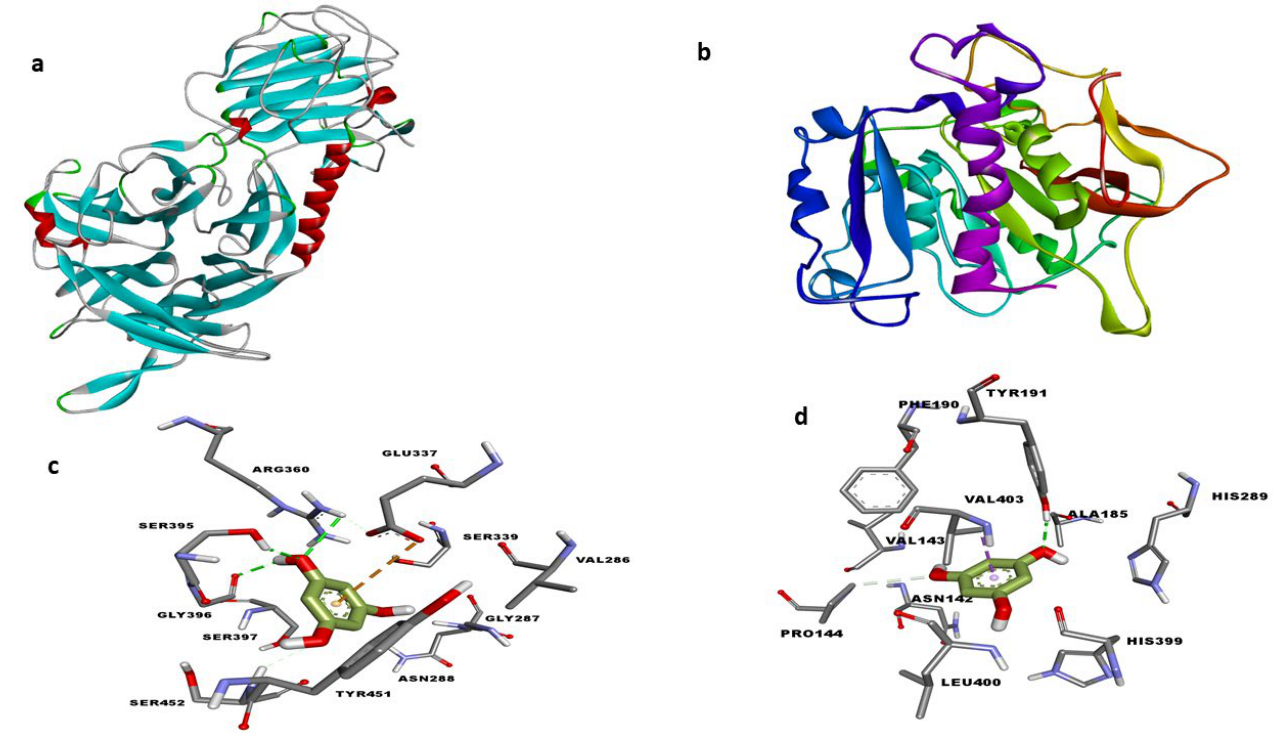
Figure 9. Homology models of trypanosomal sialidase ( a ) and PLA 2 ( b ) after 50 ns molecular dynamics simulation and 3D molecular docking interactions of phloroglucinol with the trypanosomal sialidase ( c ) and PLA 2 ( d ).